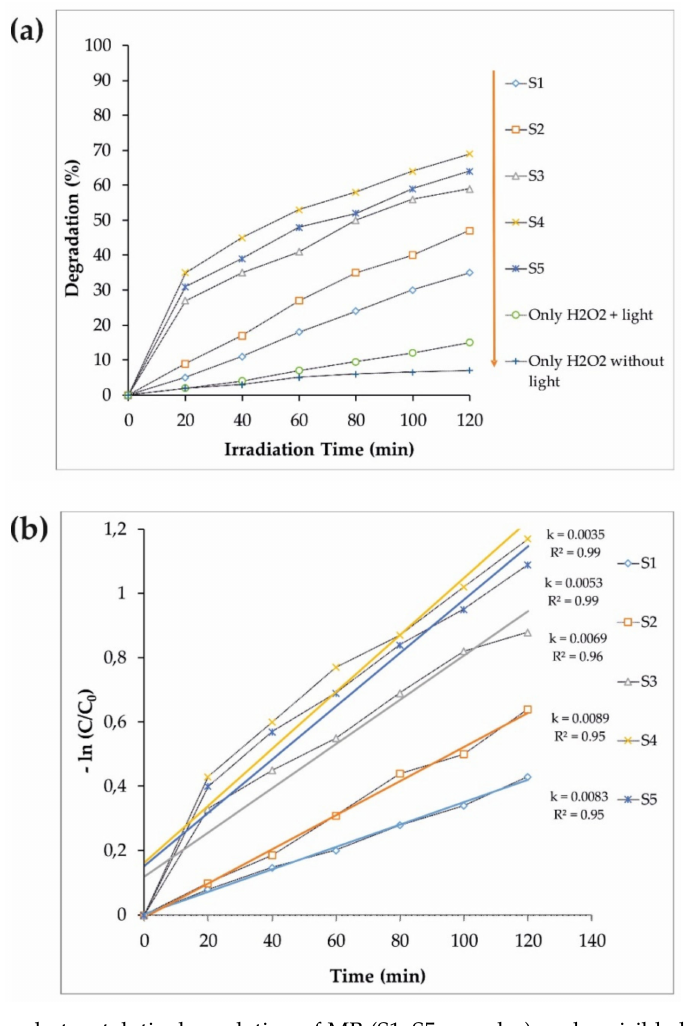
Figure 5. ( a ) The photocatalytic degradation of MB (S1–S5 samples) under visible light assisted by